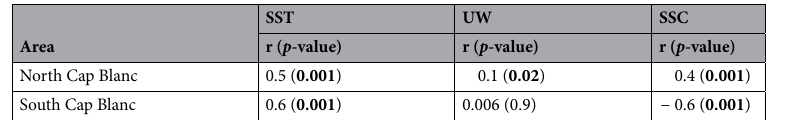
Table 1. Spearman tests for oceanographic environmental trends (favorable Upwelling Wind ‘UW’, Sea Surface Temperature ‘SST’ and Sea Surface Chlorophyll ‘SSC’) from 1995 to 2015 in North and South Cap Blanc. r: temporal linear trend in the Spearman correlation coefficient. Significant values ( p -value < 0.05) are shown in